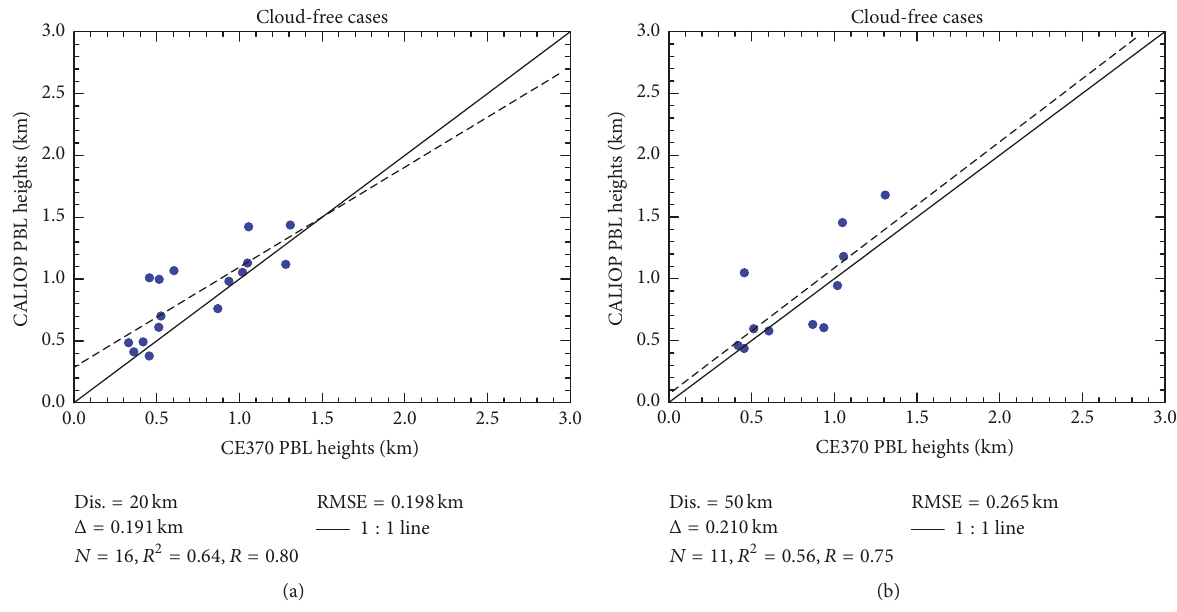
Figure 9: The comparison results of PBLH derived from CALIOP and CE370 in cloud-free cases. (a) For the threshold value of 20km, (b) for the threshold value of 50km.